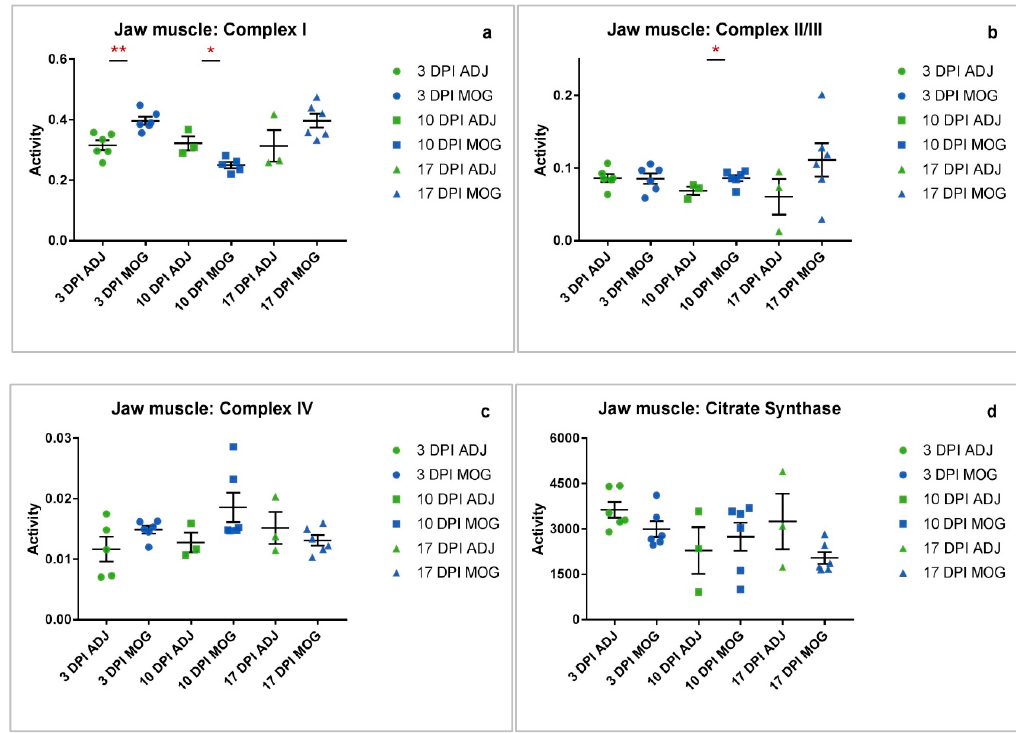
Figure 2. Jaw muscle complex activity ADJ vs. MOG at di ff erent time-points. Individual raw data points for controls (ADJ) (green) and diseased (MOG) (red) have been plotted with mean and standard error of mean (SEM) to show the distribution of complex activity. Activities shown are expressed as a ratio to CS activity. ( a ) Graph shows the distribution of complex I activity across ADJ and MOG. Complex I activity in MOG animals was significantly increased at 3 DPI (** p = 0.0029) and decreased at 10 DPI (* p = 0.0174). ( b ) Complex II / III activity in MOG animals was significantly increased at 10 DPI (* p = 0.0474). ( c ) Complex IV activity showed no significant di ff erences between MOG and ADJ animals across all three time-points. ( d ) Mitochondrial enrichment was assessed by CS activity, which showed no significant di ff erences in the jaw muscle between MOG and ADJ animals.